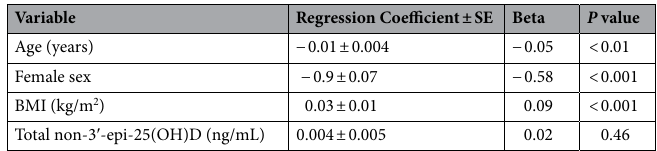
Table 4. Lack of association between total non-3 ′ -epi-25(OH)D and haemoglobin levels. Total non-3 ′ -epi- 25(OH)D was not associated with haemoglobin levels after controlling for age, sex, and BMI.